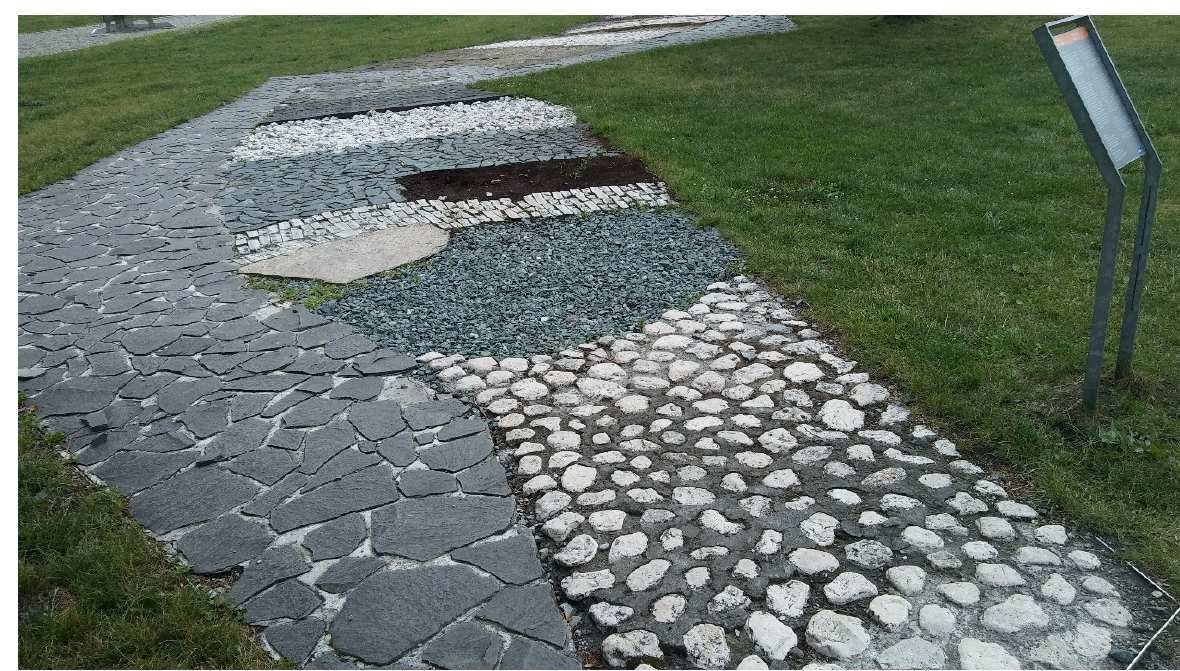
Figure 4. Diversified surface of path surface, Owi ń ska and Kraków (fot. A. Zajadacz).